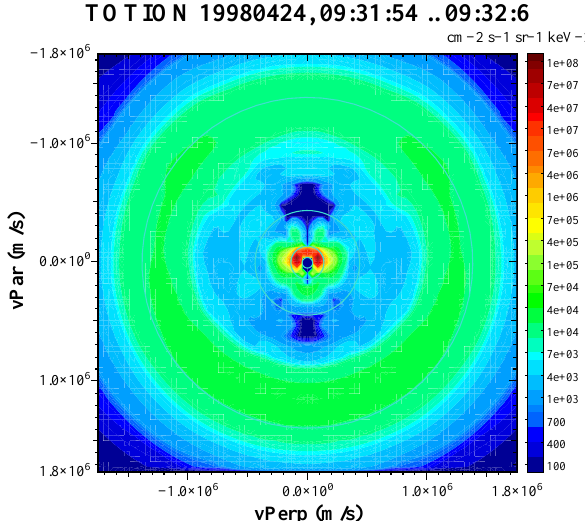
Fig. 4. Total ion distribution function from TIMAS at 09:34UT during the event shown in Fig. 2. A plateau distribution within 3 keV (0 . 75 × 10 6 m/s) with a superposed upward ion conic is seen. The blue circles correspond to energies 10 eV (0 . 044 × 10 6 m/s), 100 eV (0 . 14 × 10 6 m/s), 1 keV (0 . 44 × 10 6 m/s) and 10 keV (1 . 4 × 10 6